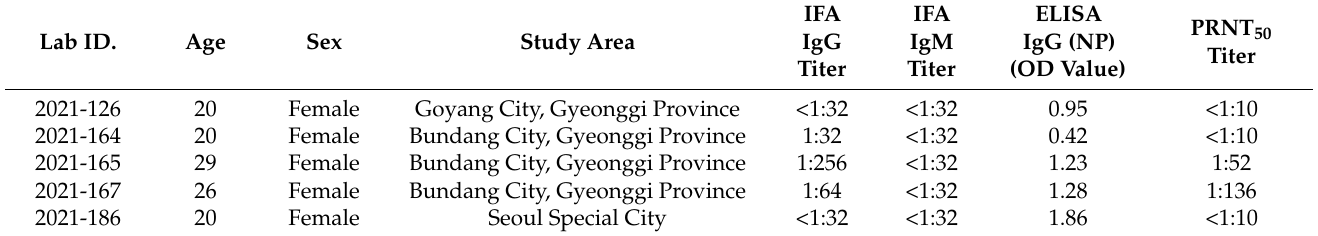
Table 2. Characteristics of the veterinary hospital workers who tested positive for anti-SFTSV